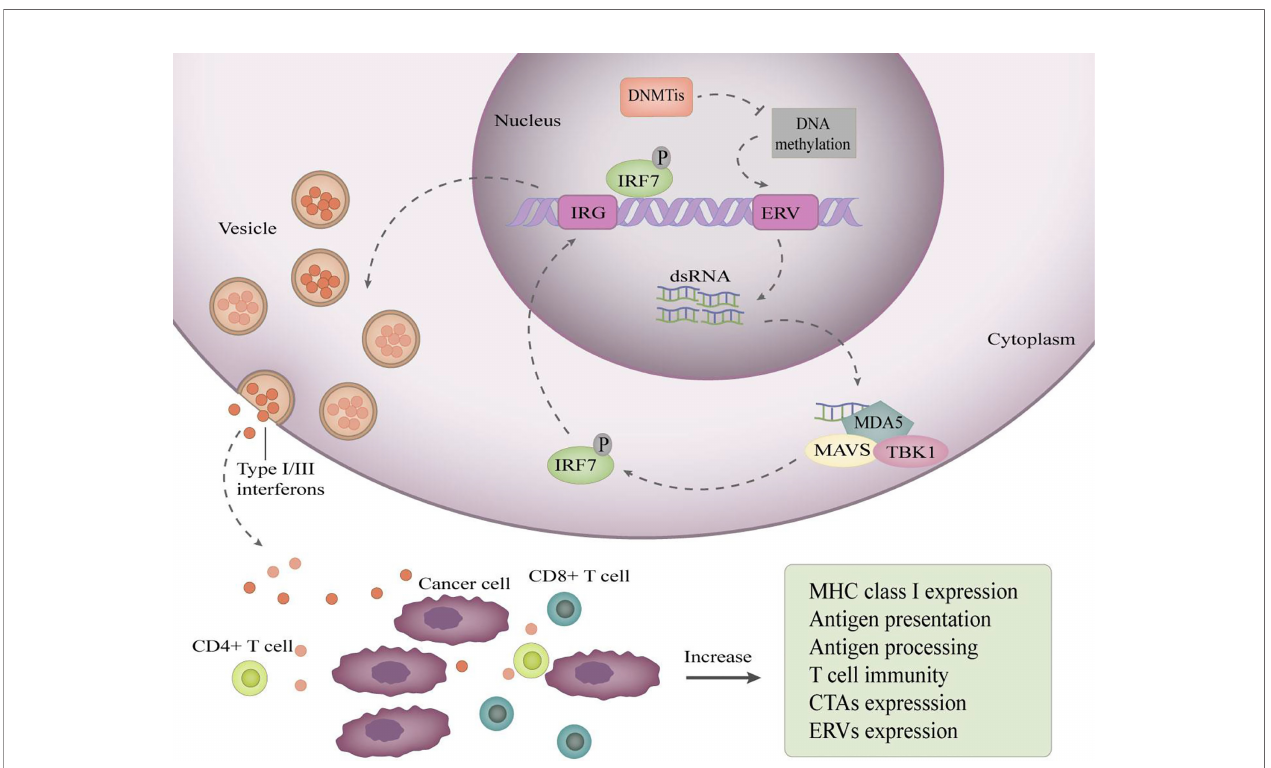
FIGURE 1 | DNA demethylation restores ERV expression to induce viral mimicry. DNA demethylating drugs reactivate ERV promoters by inhibiting their methylation, resulting in bidirectional transcription of ERVs to produce dsRNAs, which are exported to the cytoplasm and sensed by pattern recognition receptors, such as MDA5. MDA5 binding to dsRNA induces recruitment of TANK-binding kinase 1 (TBK1) and aggregation of mitochondrial antiviral signaling protein (MAVs), which activate interferon regulatory factor 7(IRF7) by phosphorylation. Then, activated IRF7 moves into the nucleus and induces transcription of interferon-responsive genes (IRG). Consequently, type I/III interferons are produced, transported, and secreted into the tumor microenvironment. Secreted type I/III interferons increase the expression of antigen processing and antigen presentation mechanisms, improving the ability of cancer cells to present